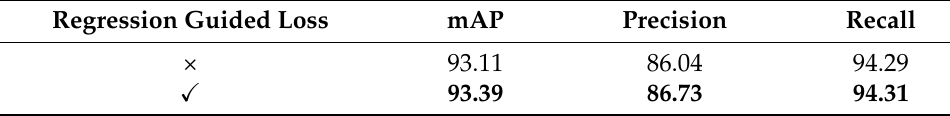
Table 4. Analysis of regression guided loss on the SSDD dataset.